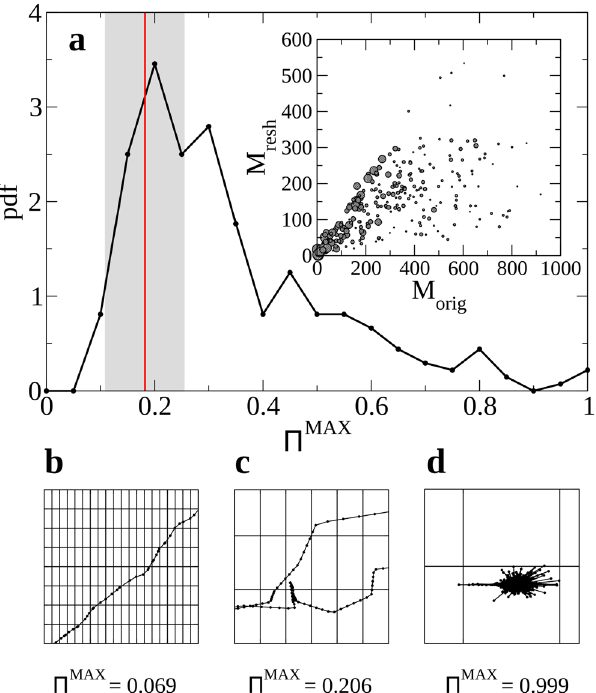
Figure 4. Analysis of the use of space. ( a ) Distribution of the limit of predictability, Π MAX . The red line indicates the average of the maximum predictability distribution for reshuffled trajectories, and the shaded area represents the range of the limit of predictability obtained for the reshuffled trajectories within a standard deviation from the average. Inset: Number of visited grid cells, for each individual, for the reshuffled ( M resh ) and the observed trajectories ( M orig ). Symbol size represents the limit of predictability of the individual trajectory. The plots ( b – d ) depict typical trajectories whose values for the limits of predictability are 0.069, 0.206, and 0.999,